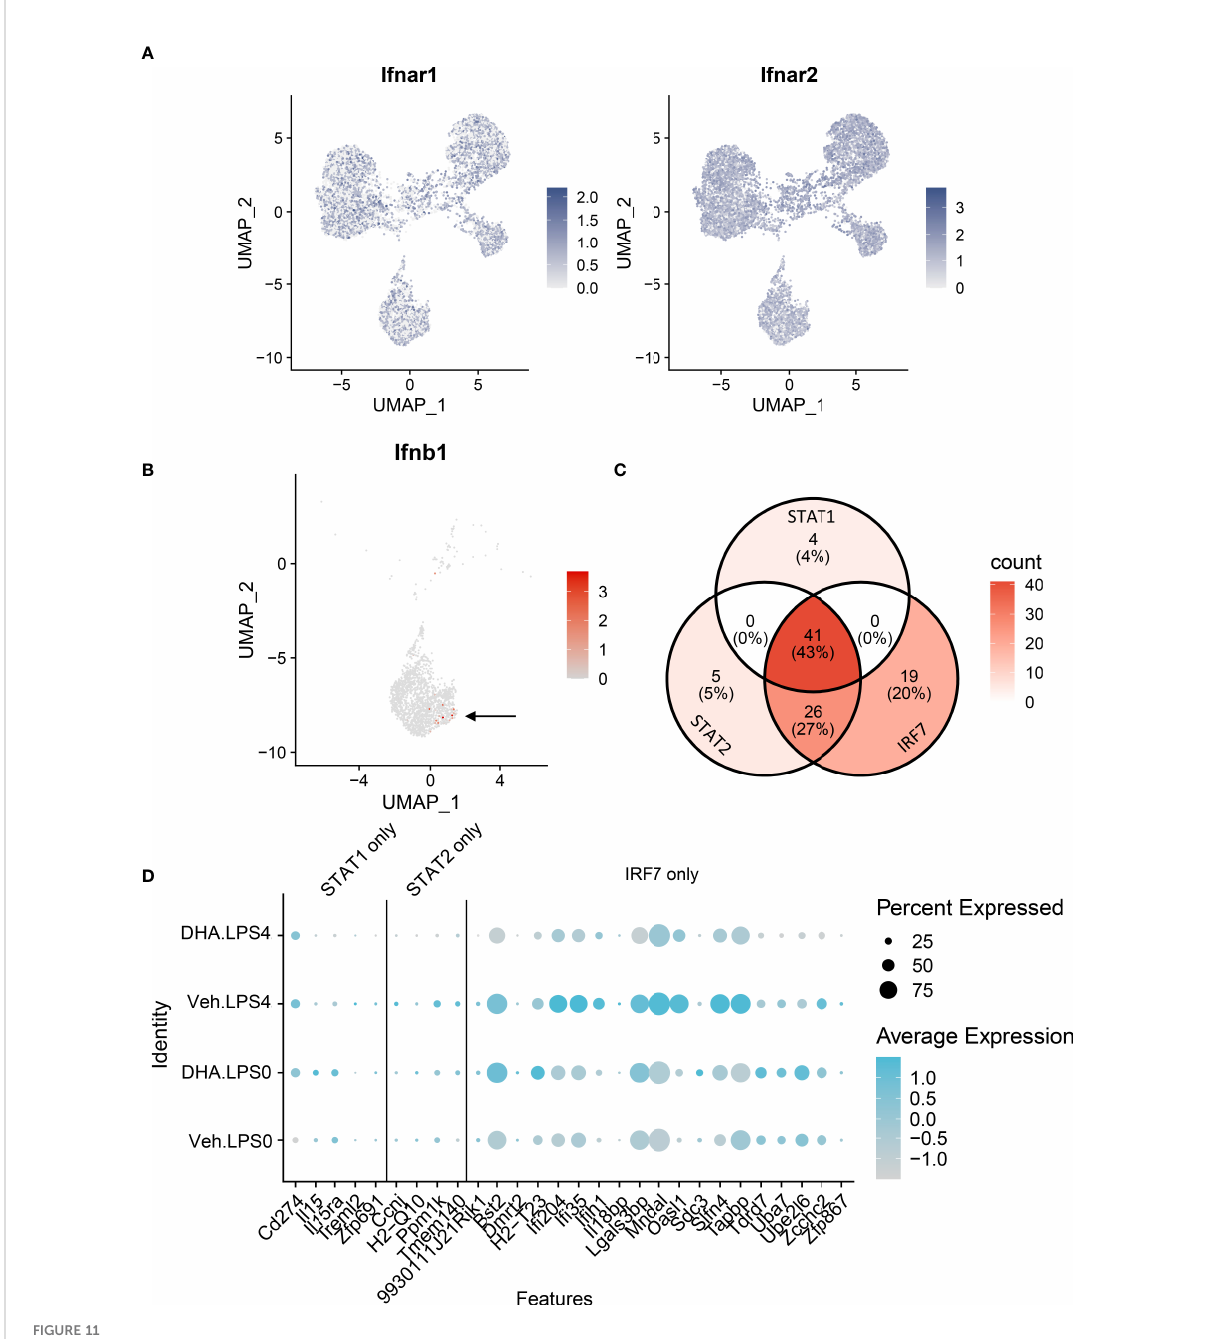
FIGURE 11 IFN1-regulated gene expression at 4 h post-LPS is driven by IRF rather than STAT activity. (A) Ifnar1 and Ifnar2 are homogenously expressed at a high level in the FLMs across the time clusters. (B) A small number of cells express Ifnb (arrow), and it is limited primarily to Veh-treated cells. (C) The majority of the genes identi fi ed in the STAT1 and STAT2 regulons are also IRF7 targets. (D) Genes driven by IRF7 alone are more highly expressed than genes driven by either STAT1 or STAT2 alone. Genes are presented using the Seurat DotPlot function, where the size of the dot indicates the percent of cells expressing the gene and the depth of the dot color indicates the average expression of the gene across the cells in which it is